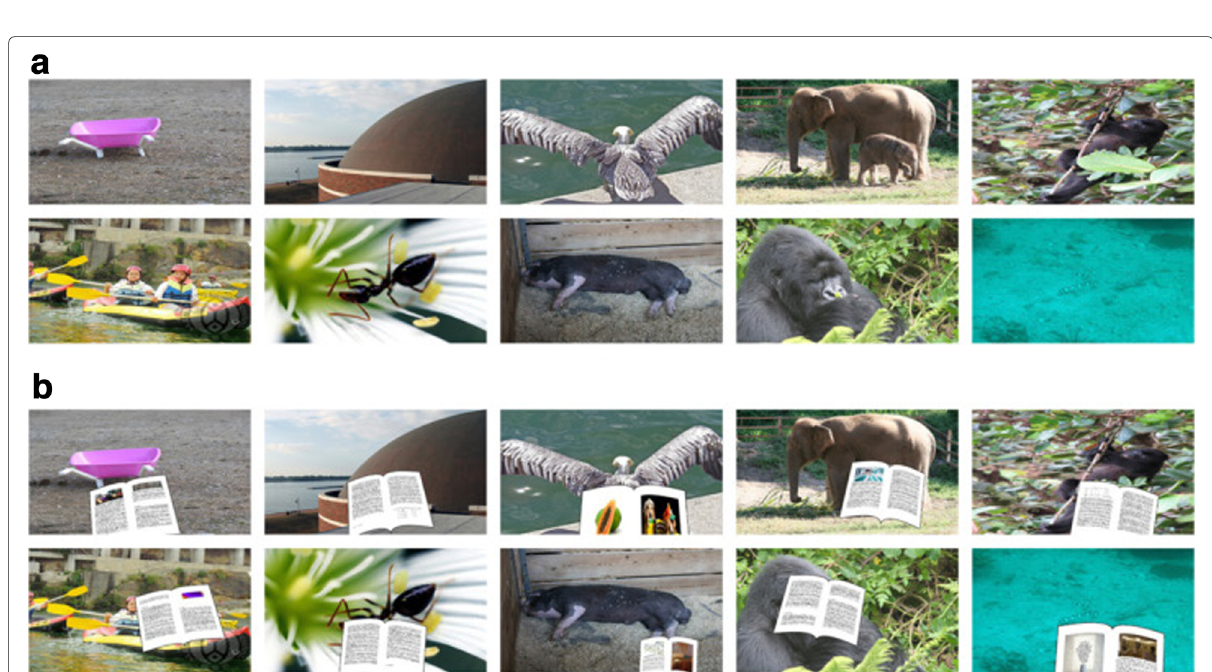
Fig. 2 Synthetic training samples. a “Others” class. b “Reading”